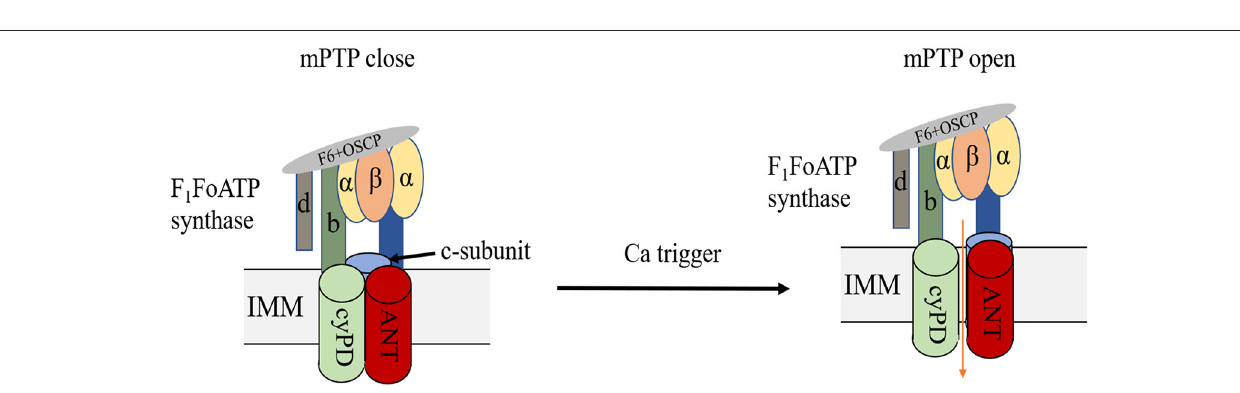
FIGURE 3 | Structure of mPTP. mPTP is a non-specific and -selective channel composed of multiple proteins, which is voltage-dependent and spans cytoplasm, OMM, IMM, and mitochondrial matrix. F 1 F 0 (F)-ATP synthase is the main component of the pore and that the regulatory molecule CypD is a protein modulator of the